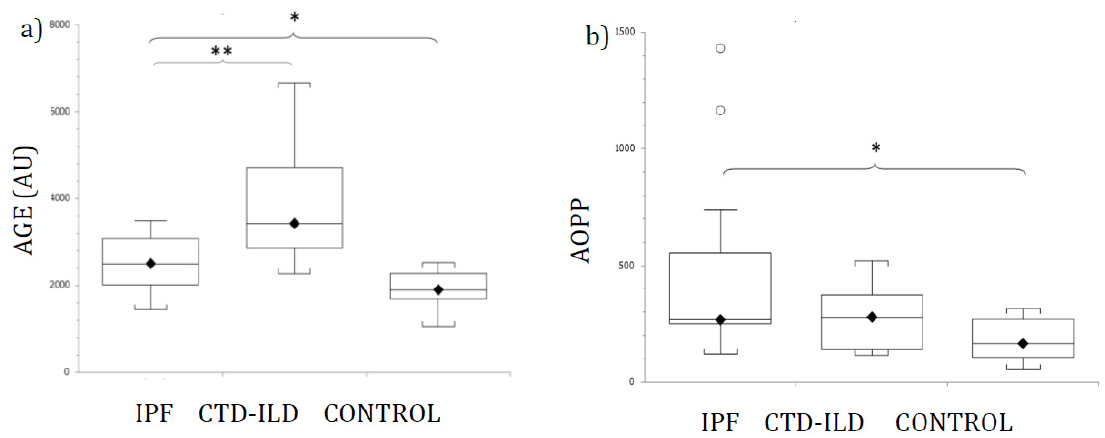
Figure 1. Levels of ( a ) AGE, and ( b ) AOPP in patients with IPF, CTD-ILD and healthy controls, expressed as mean ± SEM. Results were compared using one-way ANOVA with Tukey’s post hoc test. AGE: Advanced glycosylated end products. AOPP: Advanced oxidation protein products. IPF: Idiopathic pulmonary fibrosis. CTD-ILD: Connective tissue disease-interstitial lung disease. White circles represent outliers. *, **: p < 0.05. *: Patients versus healthy controls. **: IPF patients versus CTD-ILD patients.